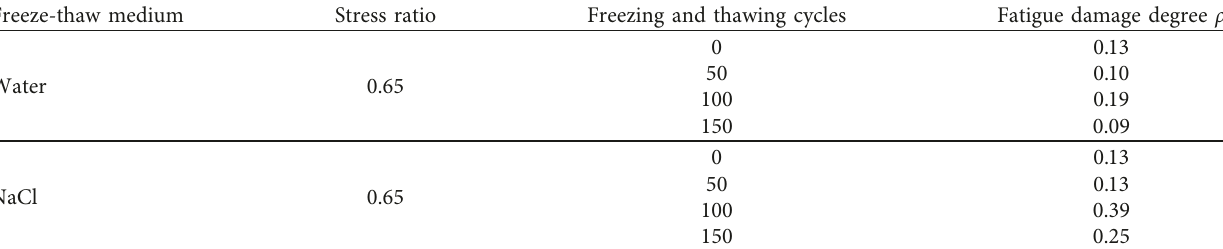
Table 8: Fatigue damage degree ρ of the test